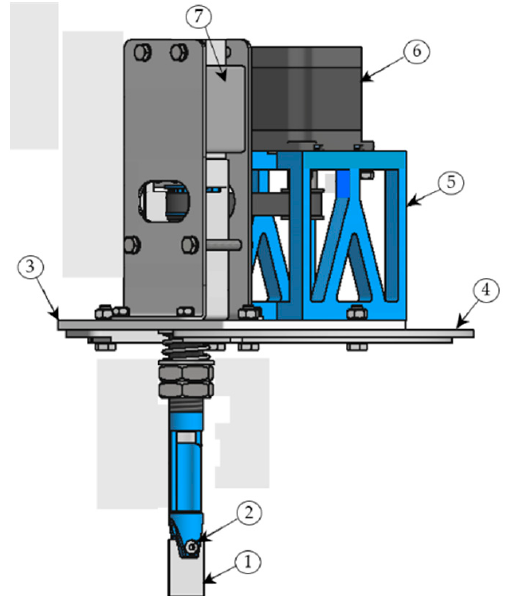
Figure 3. The CAD model of the active workpiece holder: 1—sample, 2—screw clamp, 3—sliding plate, 4—cover plate, 5—motor bracket, 6—stepper motor, 7—electromagnetic vibrator.